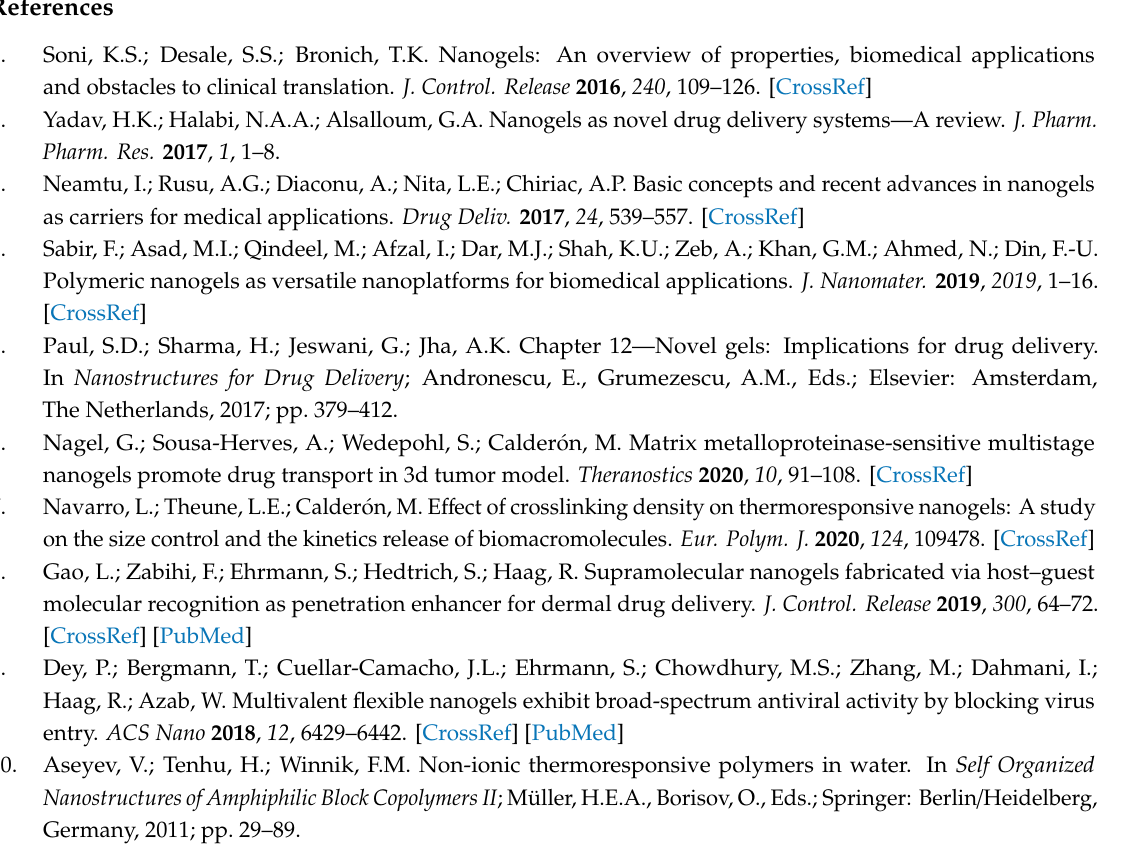
Figure S1: Schematic illustration of synthesis of (a) P(D-co-A) copolymer, (b) reaction of P(D-co-A) with 2-azido-1,3-dimethylimidazolinium hexafluorophosphate, and (c) reaction of P(D-co-A) with propargyl chloroformate, Figure S2: Absorbance of P(D-co-A) copolymers before and after modifications, Figure S3: An exemplary 1 H NMR spectra of (a) P(D-co-A)_3, (b) P(D-co-N 3 )_3, (c) P(D-co-Prop)_3 (600 MHz, in CDCl 3 ), Figure S4: An exemplary FTIR spectra of (a) P(D-co-A)_3, (b) P(D-co-N3)_3, (c) P(D-co-Prop)_3, Figure S5: Transmittance curves of (a) P(D-co-A)_1, (b) P(D-co-A)_2, (c) P(D-co-A)_3, (d) P(D-co-A)_4 and (e) P(D-co-A)_5 copolymers at di ff erent solution concentrations, Figure S6: Transmittance curves of (a) P(D-co-N 3 )_1, (b) P(D-co-N 3 )_2, (c) P(D-co-N 3 )_3, (d) P(D-co-N 3 )_4 and (e) P(D-co-N 3 )_5 copolymers at di ff erent solution concentrations, Figure S7: Transmittance curves of (a) P(D-co-Prop)_1, (b) P(D-co-Prop)_2 and (c) P(D-co-Prop)_3 copolymers at di ff erent solution concentrations, Figure S8: Size distributions of the nanoparticles before and after crosslinking reaction formed in binary aqueous solutions of (a) P(D-co-N 3 )_3 / P(D-co-Prop)_3 (R3) and (b) P(D-co-N 3 )_3 / P(D-co-Prop)_1 (R6), Figure S9: Histograms of average diameter of nanogels calculated based on 100 particles measurements, Figure S10: An AFM images and their cross sections for R1, R3, R4 and R6 nanogels, Table S1: Cloud point temperatures for water solutions of P(D-co-A), P(D-co-N 3 ) and P(D-co-Prop) copolymers at di ff erent solution concentrations, Table S2: Hydrodynamic radius R 90 of particles at di ff erent h solution